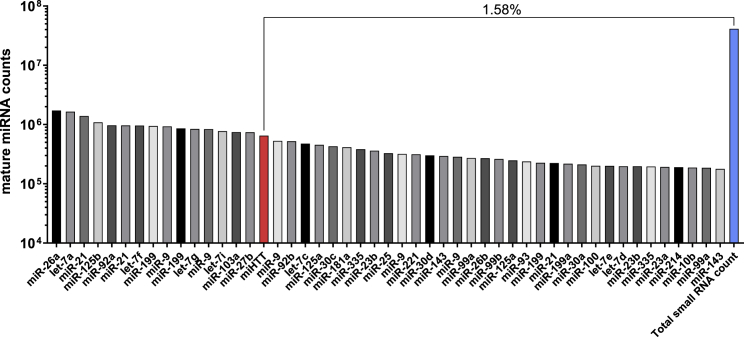
Small RNA Sequencing Analysis of AAV5-miHTT-Treated HD71 iPSC-Derived Neuronal CultureTop 50 of the most abundant small transcripts. The red bar reflects the number of mature miRNA counts that aligned to miHTT, and the blue bar reflects the total mature small RNA count.